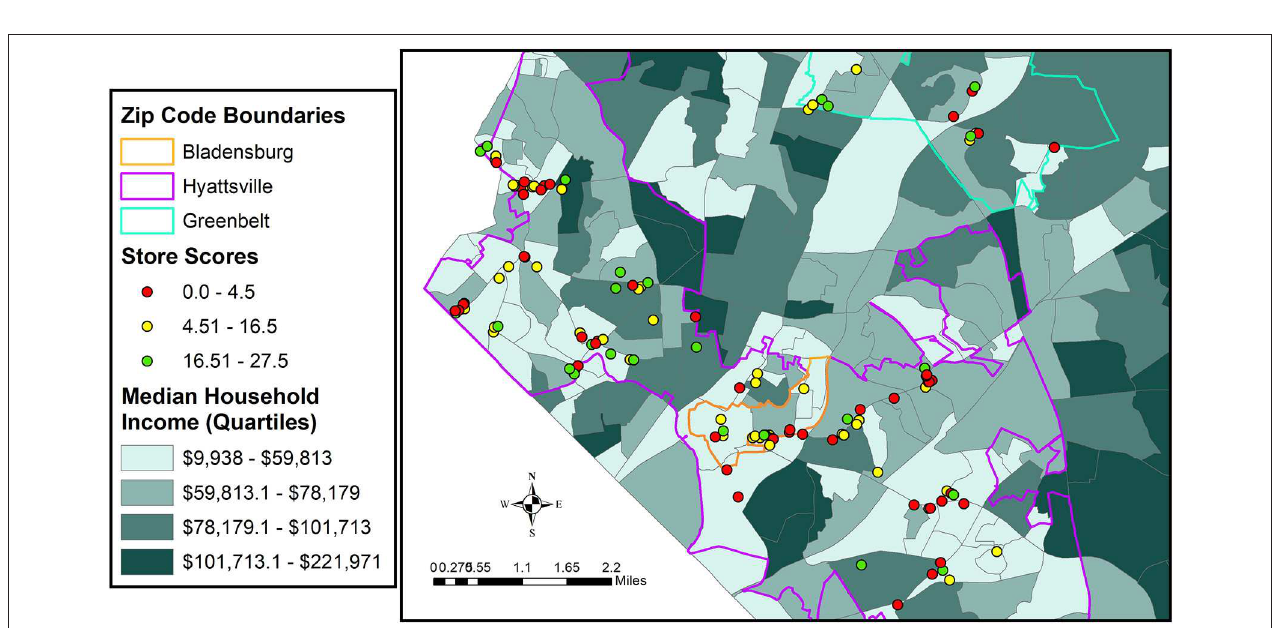
FIGURE 3 | Distribution of food store categories across Bladensburg, Greenbelt, and Hyattsville, MD (2018).